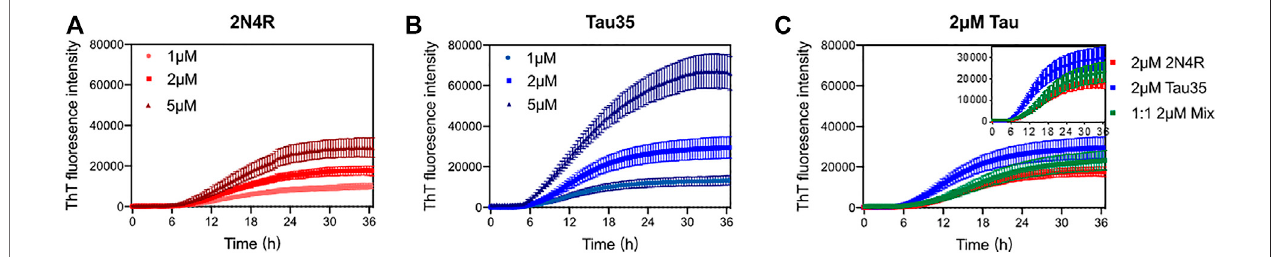
FIGURE 3 | Aggregation kinetics of 2N4R tau and Tau35. Thio fl avin T (ThT) fl uorescence curves of tau in PBS and DTT, following aggregation in the presence of heparin up to 36 h (A) 1, 2 and 5 µM 2N4R tau. (B) 1, 2 and 5 µM Tau35. (C) 2 µM 2N4R tau (red), 2 µM Tau35 (blue) and 1 µM 2N4R tau with 1 µM Tau35 (green). Values shown are mean ± SEM. 2N4R tau, n (cid:2) 8; Tau35, n (cid:2) 10; 2N4R tau with Tau35, n (cid:2) 5.